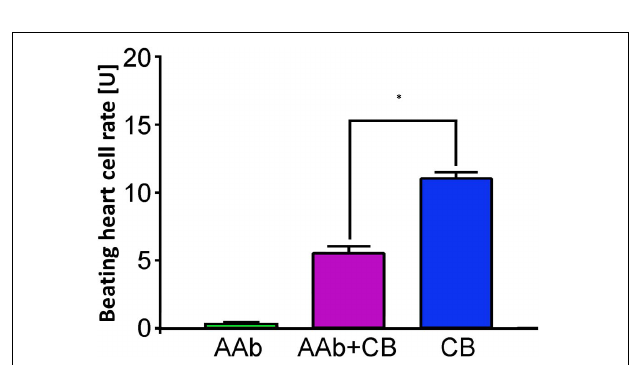
FIGURE 2 | β 2 -AAbs in patients with PEXS are of inhibitory nature. Beating heart cell rates after single application of sera of patients with PEXS without (green) and with additional clenbuterol (CB, pink); reference: single incubation with CB (blue); 1 unit (U) reflects 4 beats/min; mean ± standard deviation (SD). β 2 -AAbs inhibit the increased beating heart cell rate, due to the effect of clenbuterol, and are thus of inhibitory nature. * p < 0.001, with a post-test for multiple